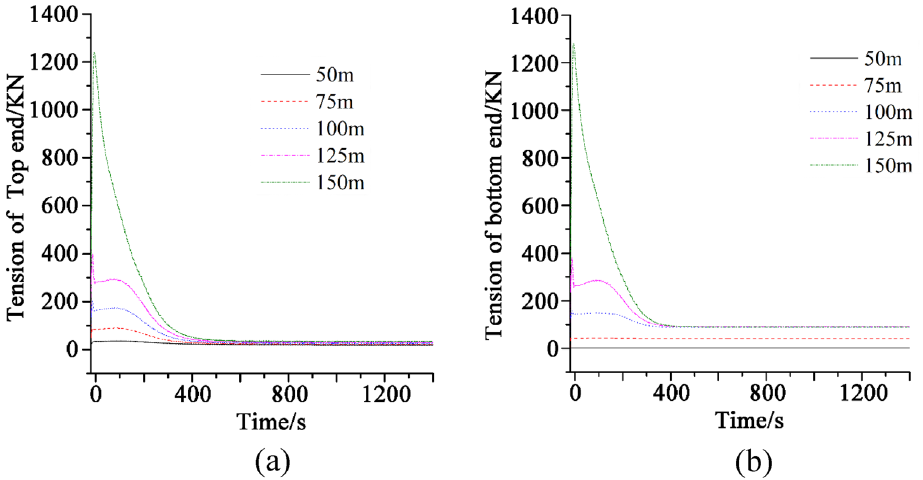
Figure 6. ( a ) Tension of the marine cable at top end at different water depths; ( b ) Tension of the marine cable at bottom end at different water depths.